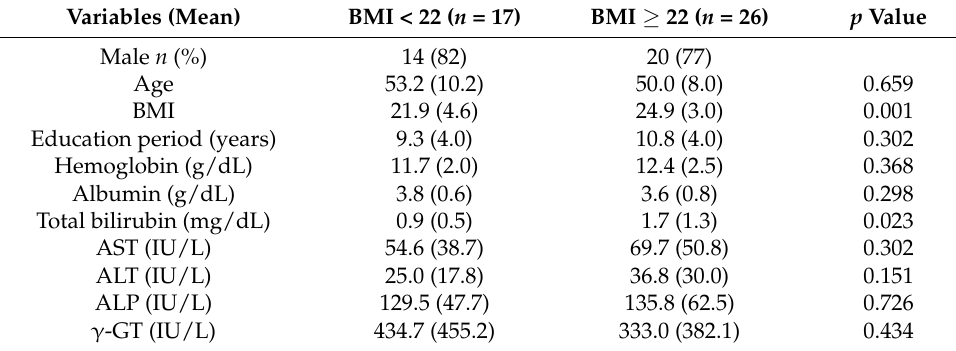
Table 2. Baseline characteristics of patient with compensated alcoholic cirrhosis. Variables